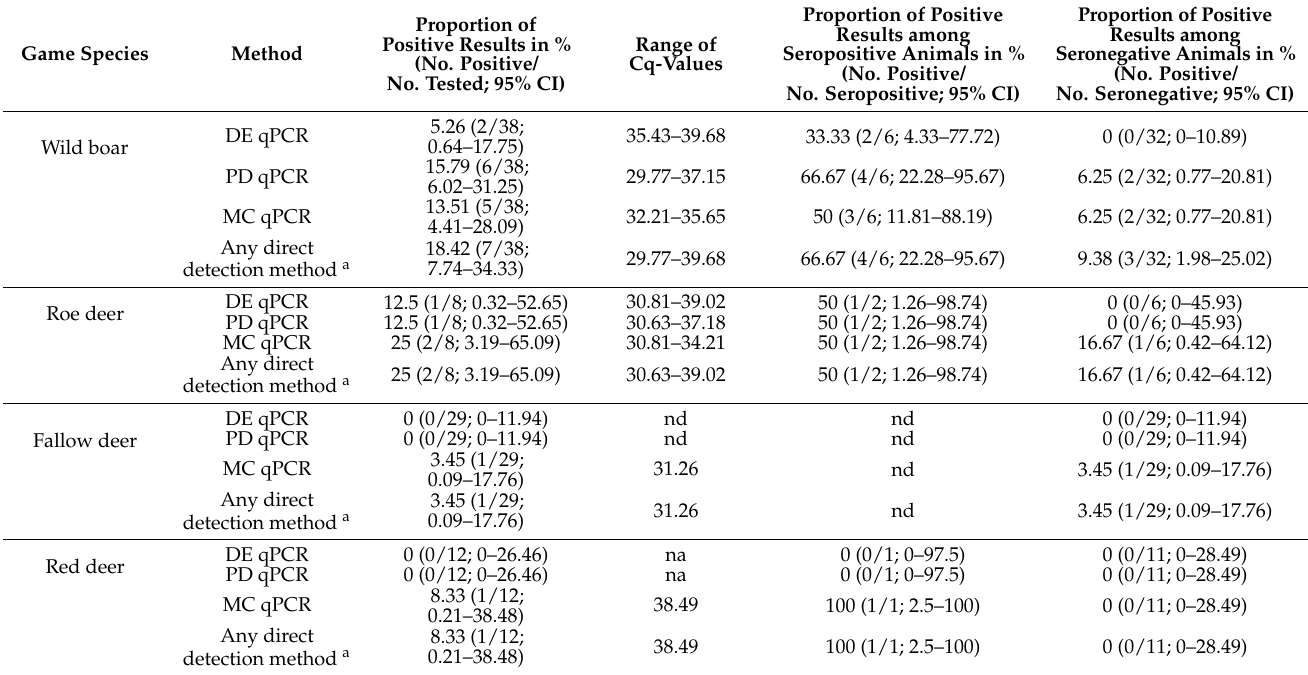
Table 6. Proportion of positive results in direct detection of Toxoplasma gondii in individuals analysed by using all three direct detection methods in total and in correlation to the